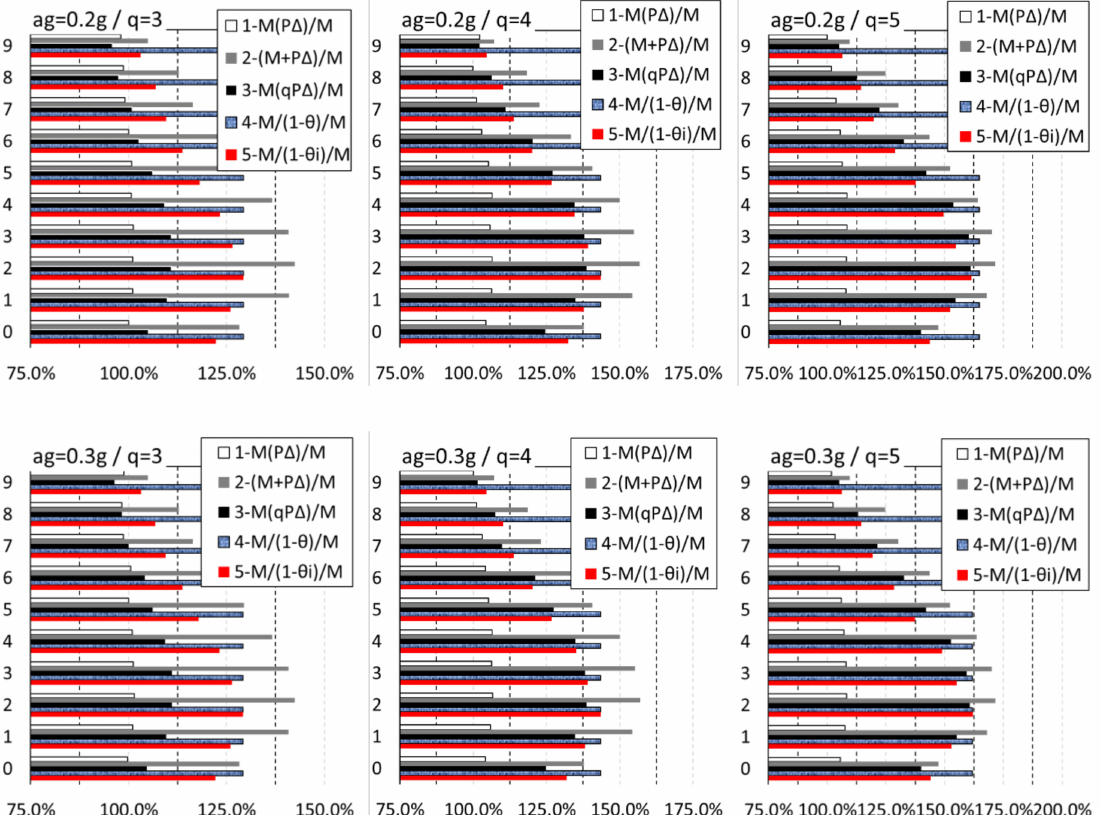
Figure 7. Influence of the q factor and ground acceleration in the P - ∆ e ff ect of nine-story steel resisting frame structure. Illustration of di ff erent approaches for the estimation of the maximum acting moment in the story